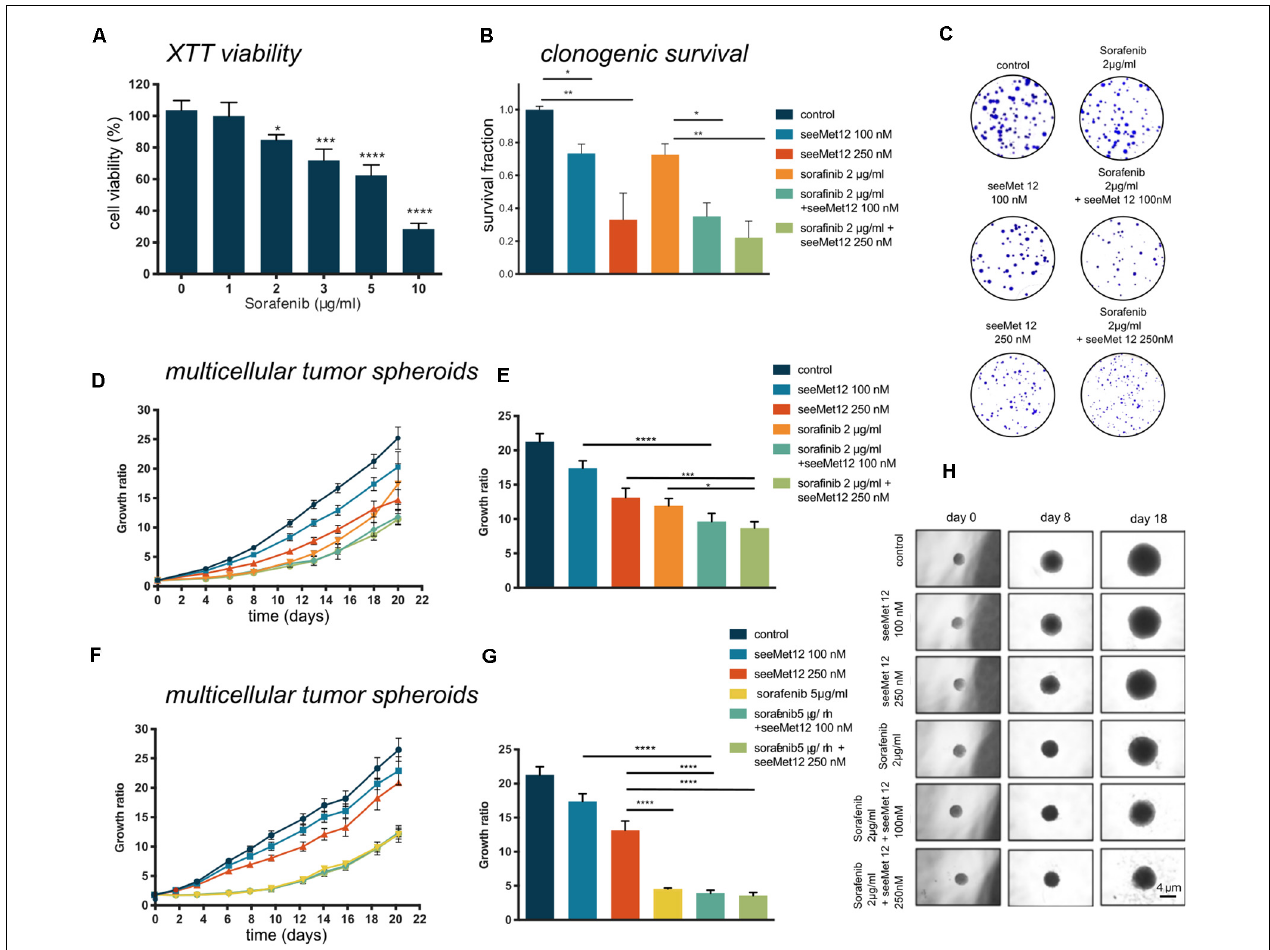
FIGURE 3 | Characterization of seeMet 12 therapy in combination with sorafenib treatment. (A) Cell viability (XTT assay) of HT-29 cells after exposure of 1–10 µ g/ml sorafenib. N > 3, Error bars represent SD. (B) Clonogenic survival assay of HT-29 cells treated with seeMet 12, sorafenib, or the combination of the two. Cells were exposed to 100 or 250 nM seeMet 12 and 2 µ g/ml sorafenib, N = 4, error bars represent SD. (C) Representative images of the colonies in the clonogenic survival assay after 14 days. (D) Multicellular HT-29 tumor spheroid assay treated with 100 or 250 nM seeMet 12 and/or 2 µ g/ml sorafenib. n = 10 for control, n = 5 for treatment groups. Error bars represent SD. (E) Comparison of the spheroid sizes in panel (D) on day, 18 Error bars represent SD. (F) Multicellular HT-29 tumor spheroid assay with 100 or 250 nM seeMet 12 and/or 5 µ g/ml sorafenib. n = 10 for control, n = 5 for treatment groups. Error bars represent SD. (G) Comparison of the spheroid sizes in panel (F) on day 18. Error bars represent SD. (H) Representative images of the spheroids after the different treatments. Size reference bar = 4 µ m. Considered to be statistically significant * p < 0.05, ** p < 0.01, *** p < 0.001, **** p <